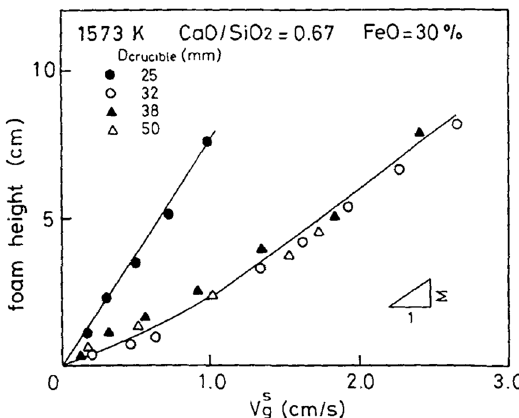
Figure 2: Relationship between slag height and superficial gas velocity for several crucible